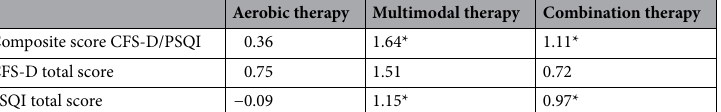
Table 4. Standardized effect sizes (Cohens d) of changes between baseline (T0) and four years later (T3) regarding CFS-D and PSQI for randomized patients, n = 39. * p < 0.05 for MT versus AT and CT versus AT. CFS-D cancer fatigue scale German version, PSQI Pittsburgh Sleep Quality